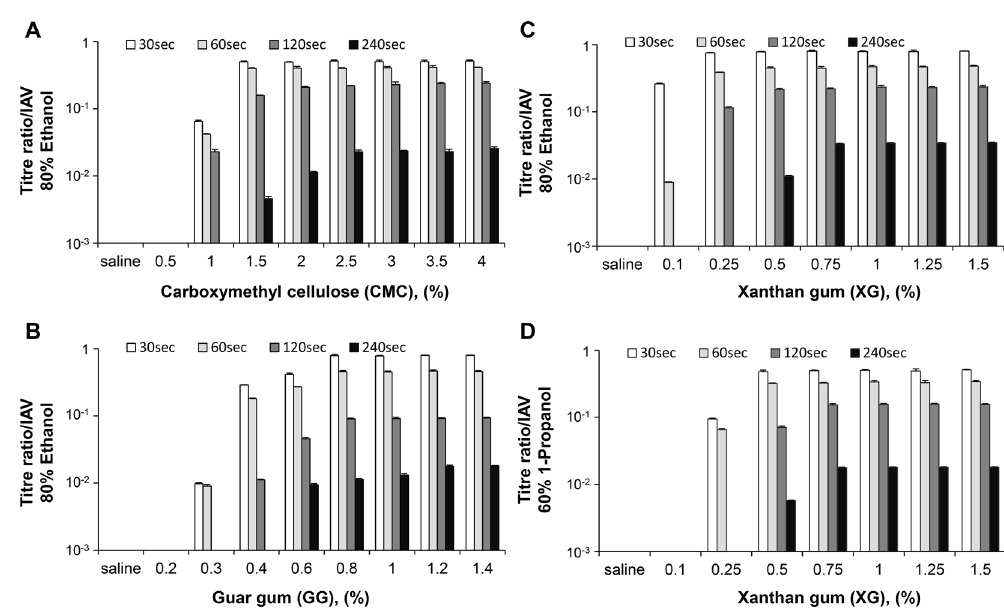
Figure 6. Effects of alcohol-based disinfectants over time on viral titre ratios. IAV was mixed with artificial mucus and incubated for 30, 60, 120, and 240 s with alcohol-based disinfectants (80% ethanol or 60% 1-propanol) before viral titre ratio was measured. ( A – C ) Titre ratios of IAV mixed with carboxymethyl cellulose-based ( A ), guar gum-based ( B ), and xanthan gum-based ( C ) artificial mucus followed by incubation with 80% ethanol. ( D ) Titre ratios of IAV mixed with xanthan gum-based artificial mucus and incubated with 60% 1-propanol. Data are expressed as the mean ± SD based on at least three independent